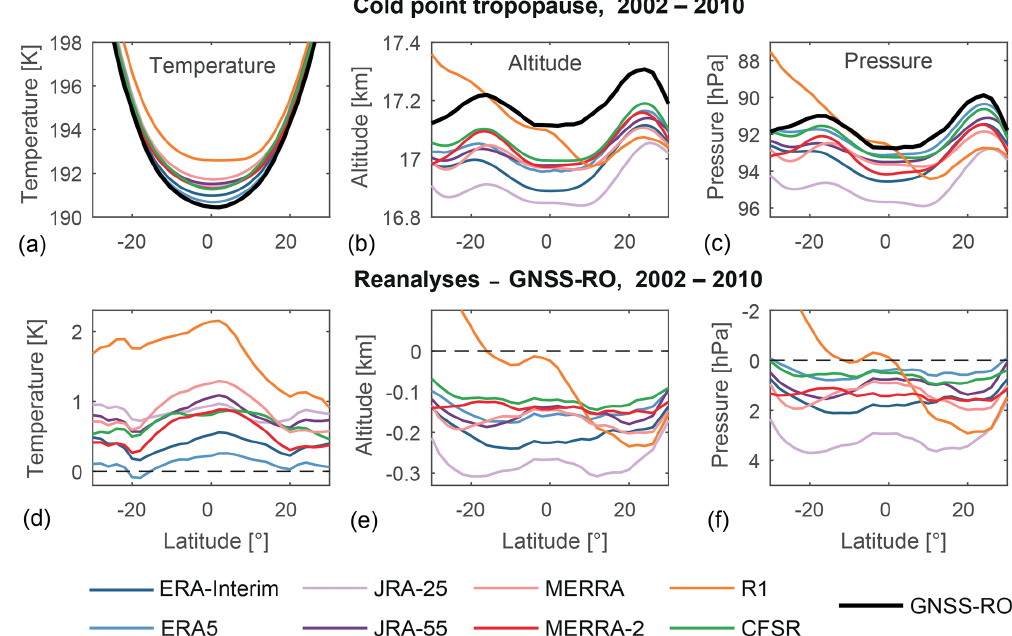
Figure 6. Latitudinal distributions of zonal-mean cold point tropopause temperature (a) , altitude (b) , and pressure (c) based on radio occul- tation data and reanalysis products during 2002–2010 (a–c) . Differences between radio occultation and reanalysis estimates are shown in panels (d) – (f)